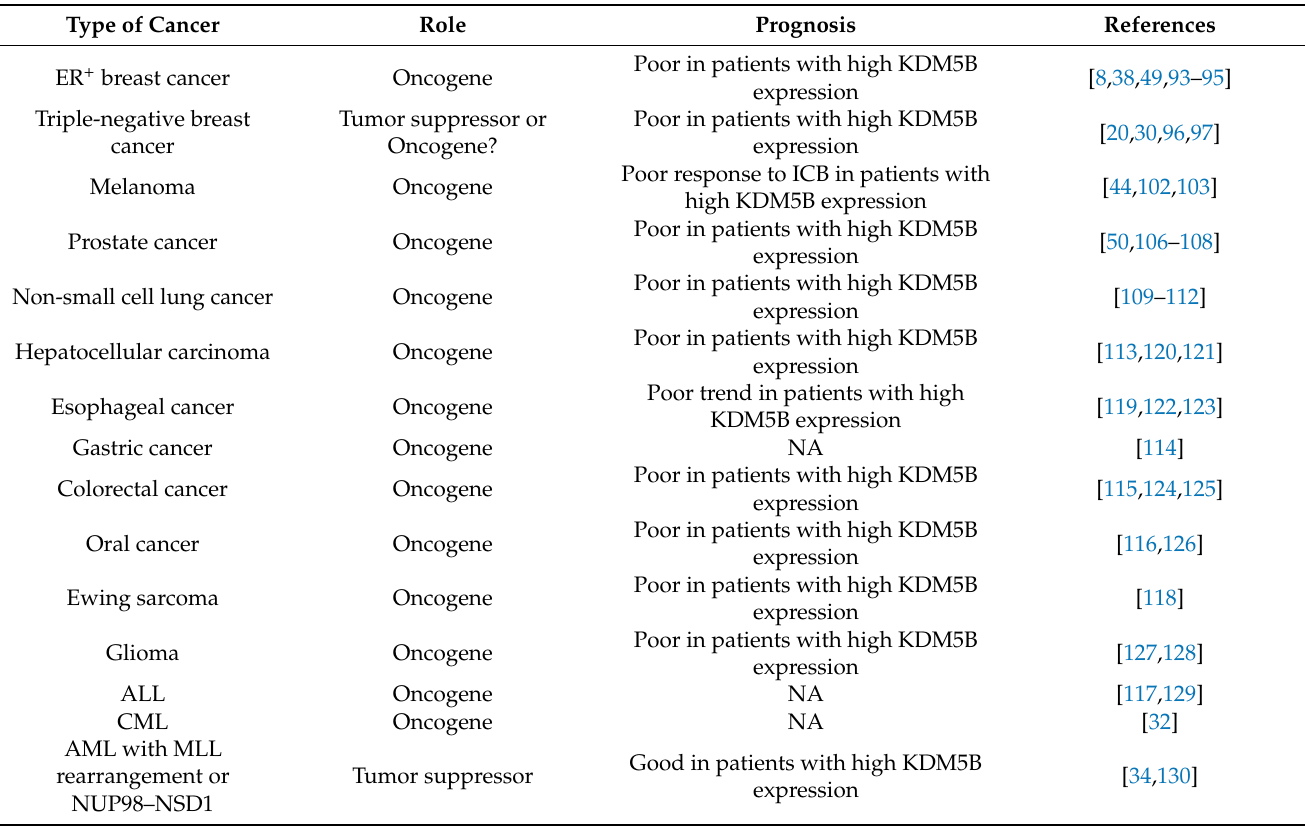
Table 2. The role of KDM5B in each type of